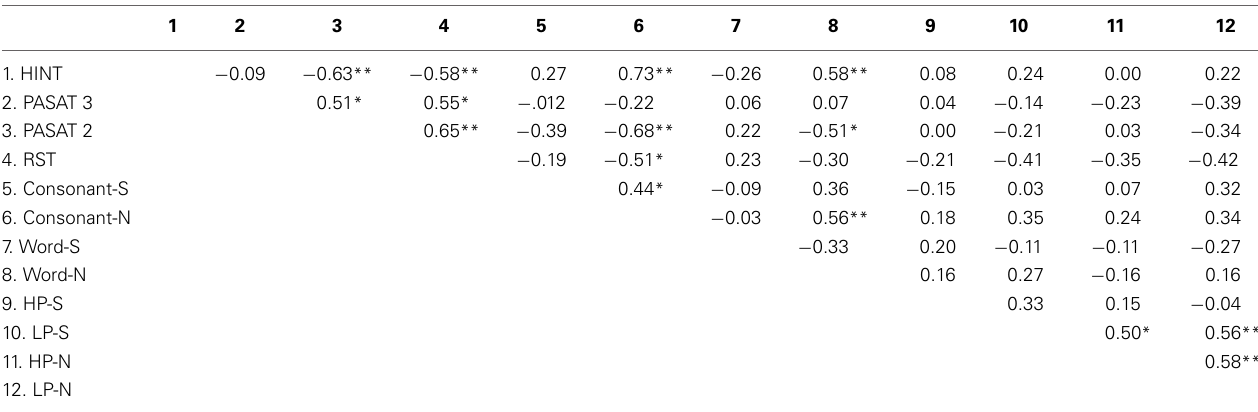
Table 3 | Correlation matrix for gating speech variables, HINT, and cognitive test results.